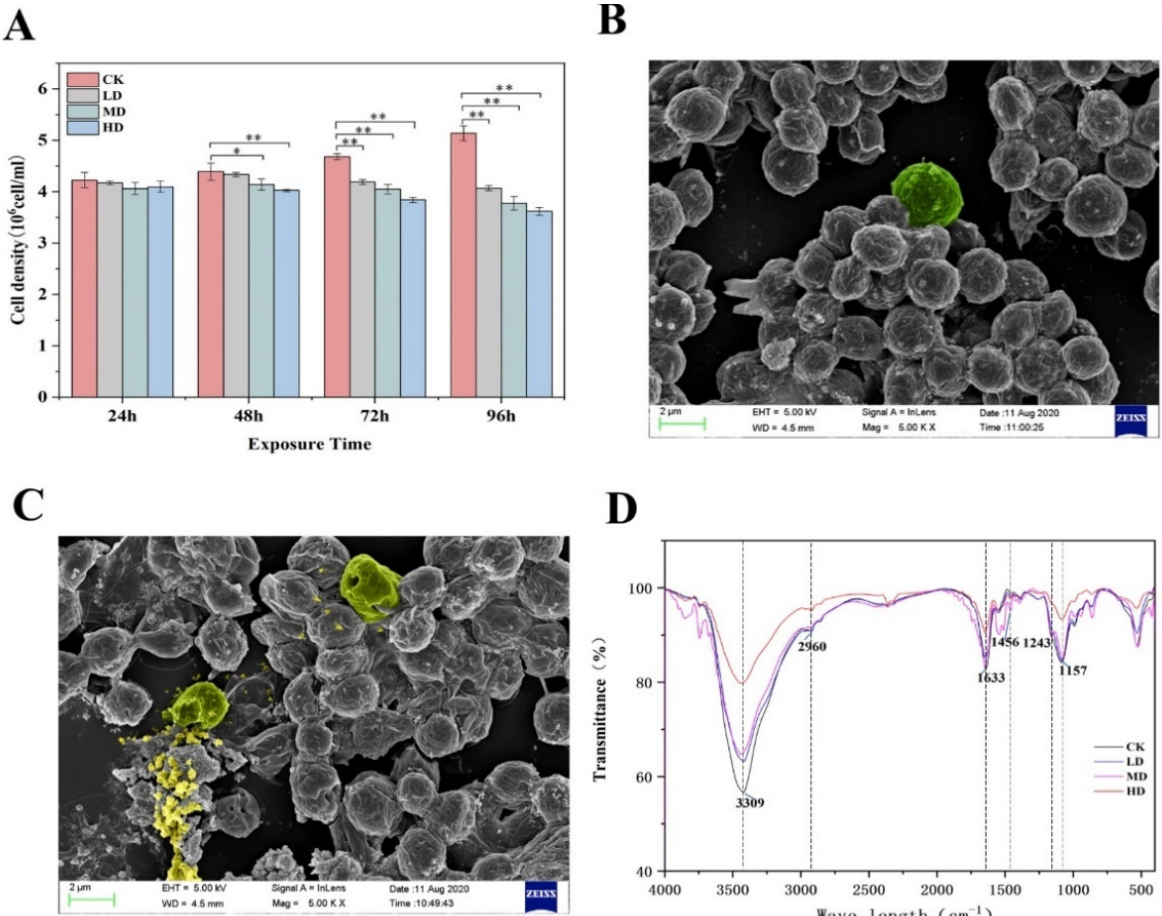
Figure 1. Effects of 17 α -EE 2 concentrations on the growth of C. pyrenoidosa within 96 h ( A ). SEM images of C. pyrenoidosa without 17 α -EE 2 and with 17 α -EE 2 at 96 h of exposure ( B , C ). FTIR analysis of C. pyrenoidosa cells treated with 17 α -EE 2 ( D ). * and ** represent statistically significant differences with respect to the values of control cultures at p < 0.05 and at p < 0.01 levels, respectively. CK: control; LD: low dose; MD: moderate dose; HD: high dose.